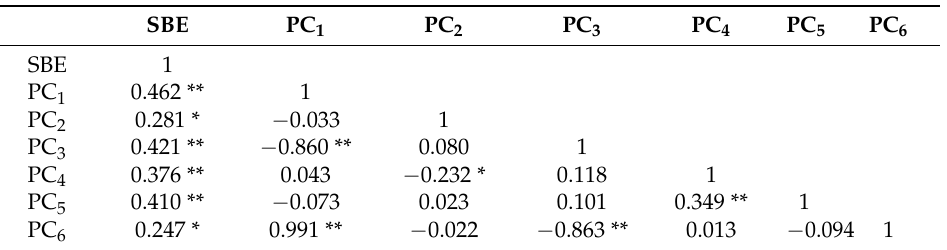
Table 4. Pearson correlation between simplified color factors and SBE values.